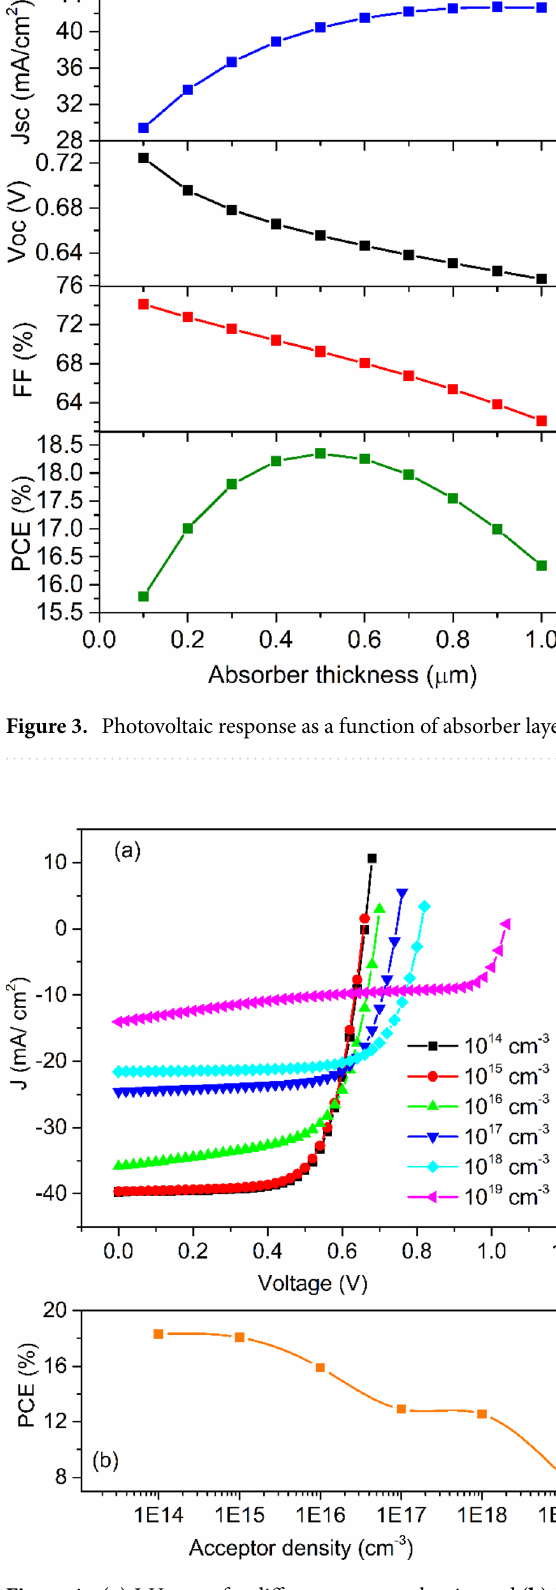
Figure 4. ( a ) J-V curve for different acceptor density and ( b ) PCE versus acceptor